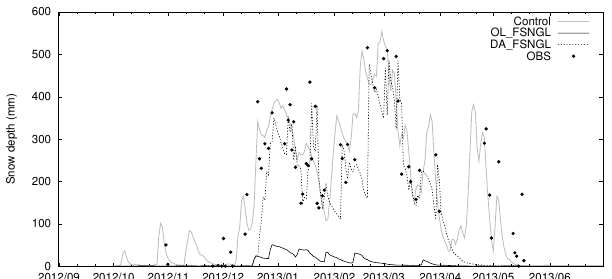
Figure 2. Snow depth time series for the water year of 2012– 2013 from the open loop (OL_FSNGL) and data assimilation (DA_FSNGL) integrations using a single forcing dataset, for the synthetic snow data assimilation experiment. The control simula- tion and the simulated observations are also